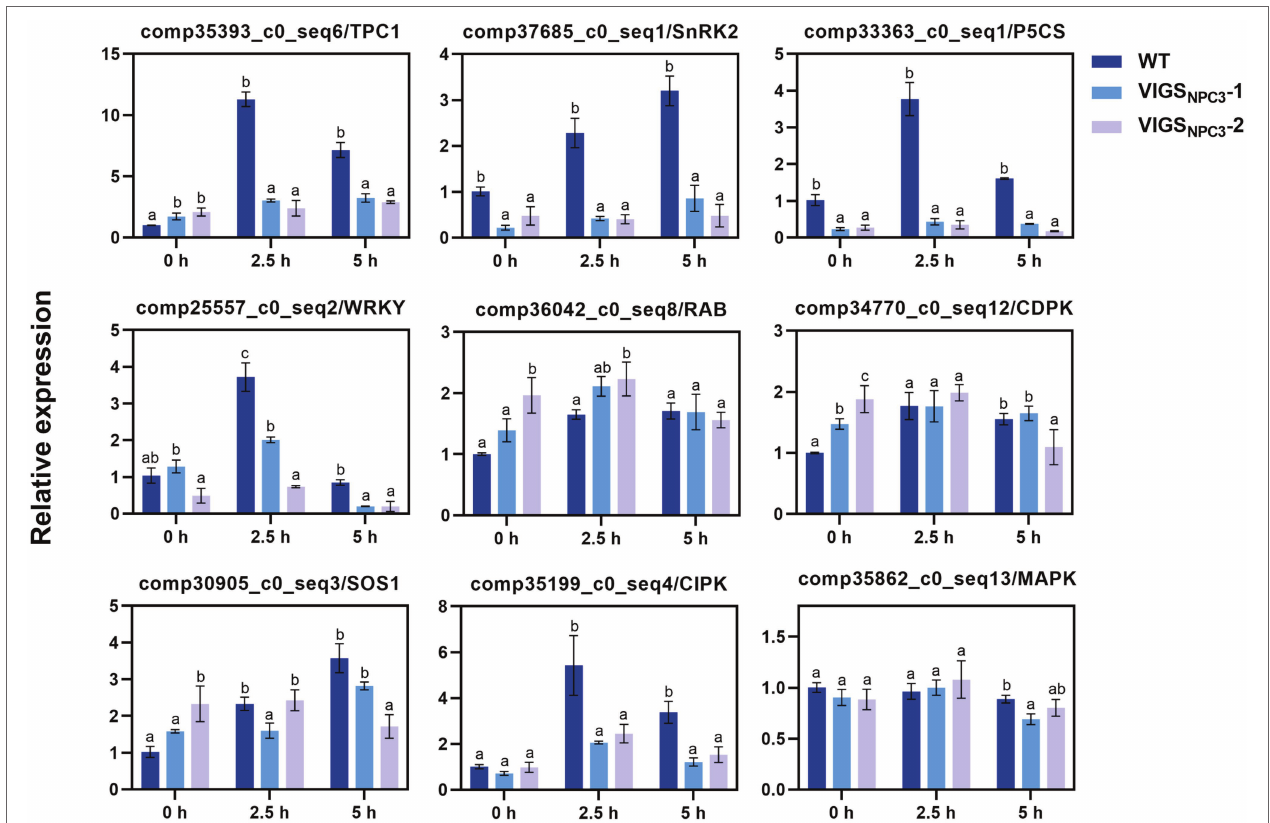
FIGURE 8 | Relative expression of stress-related genes in G. littoralis WT, VIGS NPC3 -1, and VIGS NPC3 -2 leaves. For NaCl treatment, the pot-cultured G. littoralis plants were watered with Hoagland’s culture solution containing 200 mM NaCl. Data represent means ± SD three biological replicates. Different letters above each bar indicate significant differences ( p < 0.05, Duncan’s multiple range test). GlEXP1 was used as the internal